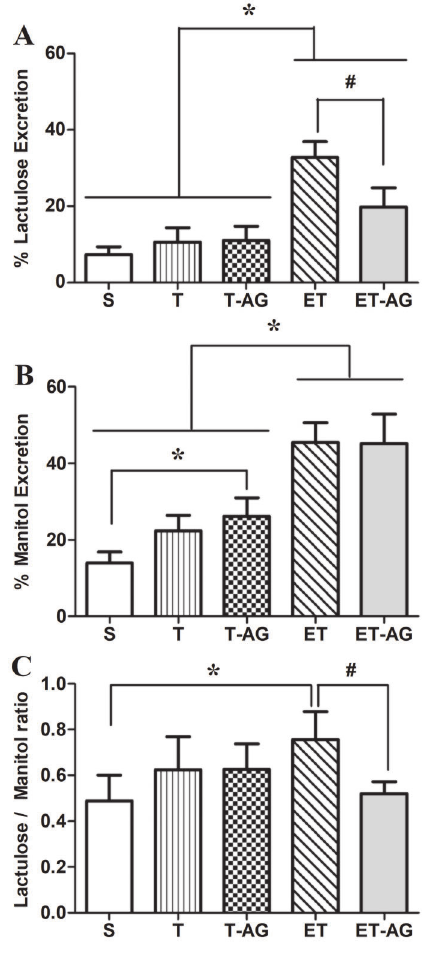
Figure 2. Intestinal permeability was evaluated by the percentage of lactulose, mannitol, and lactulose/mannitol ratio. Animals were subdivided into 5 groups: sedentary without supplementation (S), trained animals without supplementation (T), trained animals supplemented with alanyl-glutamine (T-AG), trained animals subjected to an exhaustive test without supplementation (ET), and trained animals subjected to an exhaustive test and sup- plemented with alanyl-glutamine (ET-AG). The data are reported as means ± SD (n=8). *P o 0.05 compared with S; # P o 0.05 compared with ET (ANOVA followed by Bonferroni post hoc